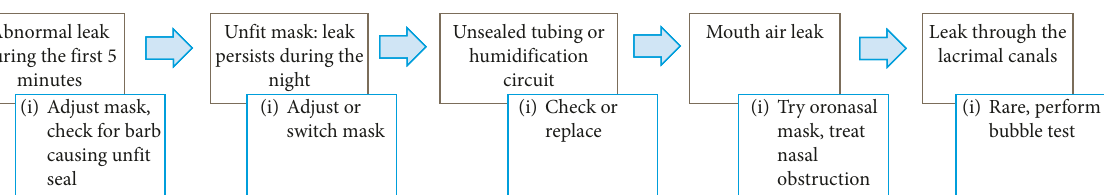
Figure 9: Checklist for managing mask leak.